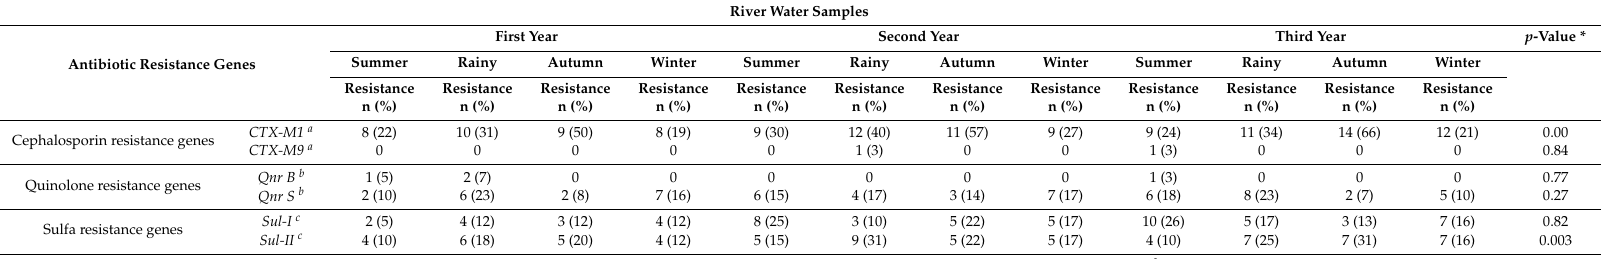
Sulfaresistancegenes River water samples—first, second, and third year, respectively. a Summer-35 / 30 / 37, Rain-32 / 30 / 32, Autumn-18 / 19 / 21, Winter-42 / 33 / 55. b Summer-20 / 40 / 32, Rain-26 / 23 / 34, Autumn-25 / 21 / 26, Winter-43 / 39 / 49. c Summer-40 / 32 / 38, Rain-33 / 29 / 28, Autumn-24 / 22 / 22, Winter-33 / 28 / 44. * The p -value is a comparison of the prevalence of genes in isolates in di ff erent seasons over three years. Table 3. Antibiotic resistance genes detected in resistant E. coli isolated from sediment samples of the Kshipra river in India in various seasons over a 3-year period. RiverSedimentSamples FirstYear SecondYear ThirdYear p -Value* Summer Rainy Autumn Winter Summer Rainy Autumn Winter Summer Rainy Autumn AntibioticResistanceGenes